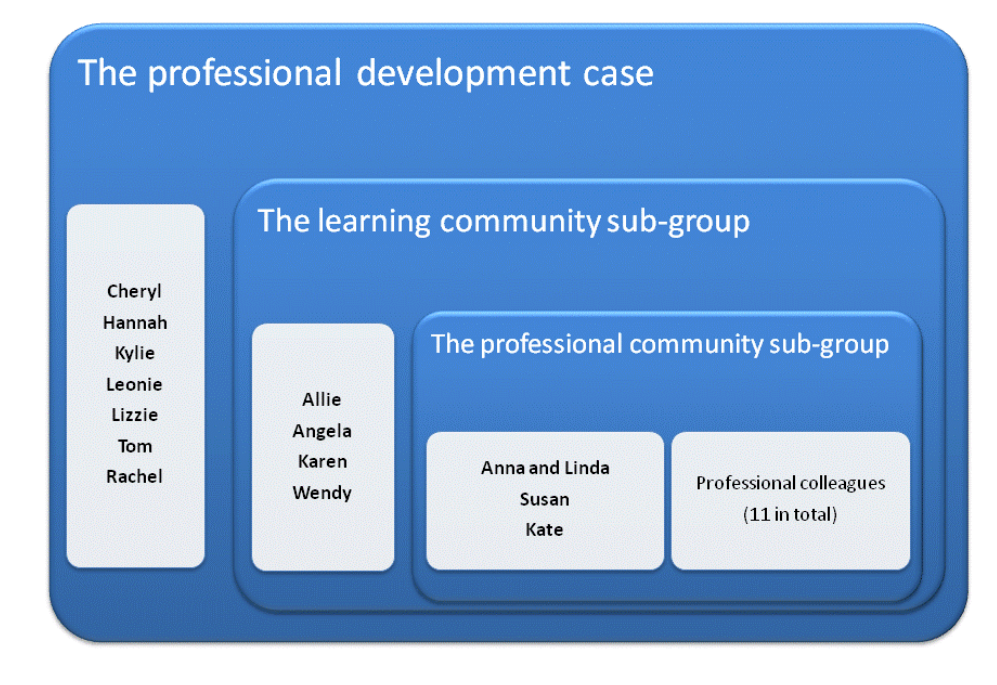
Figure 1. Embedded case